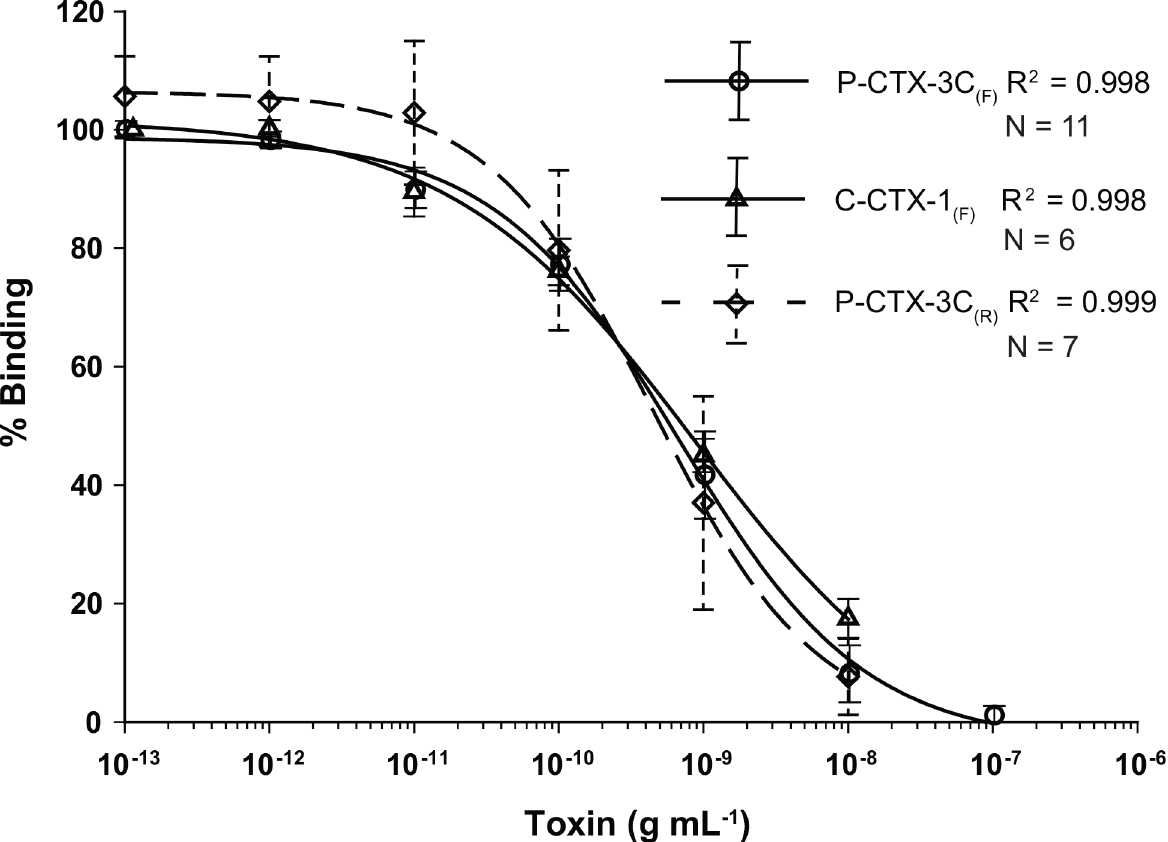
Fig 1. RBA (F) and RBA (R) Ciguatoxin Standard Binding Curves. Comparison showing the similarity of the binding kinetics (percent [%] binding vs. toxin concentration [g mL -1 ]) between the fluorescent (RBA (F) , open circle; solid line) and radioactive receptor binding (RBA (R) , open triangle; solid line) assays when P-CTX-3C was used as the standard. Also shown are the RBA (F) binding kinetics when C-CTX-1 was used as the standard (open triangle; solid line). Error bars equal ± one standard deviation with solid lines representing RBA (F) standard deviations and dashed lines for the RBA (R) results.